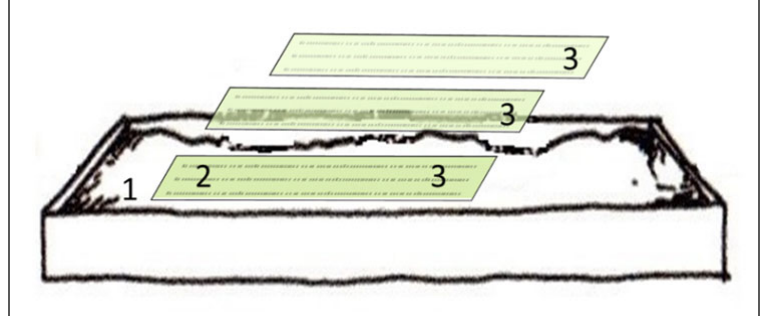
Figure 5. Different Levels of Surface Area Analysis 1. Total plot surface area (S t ); 2. Cultivated area (S c ); 3. Developed area (S d ). In this example, three crops are planted successively during the growing